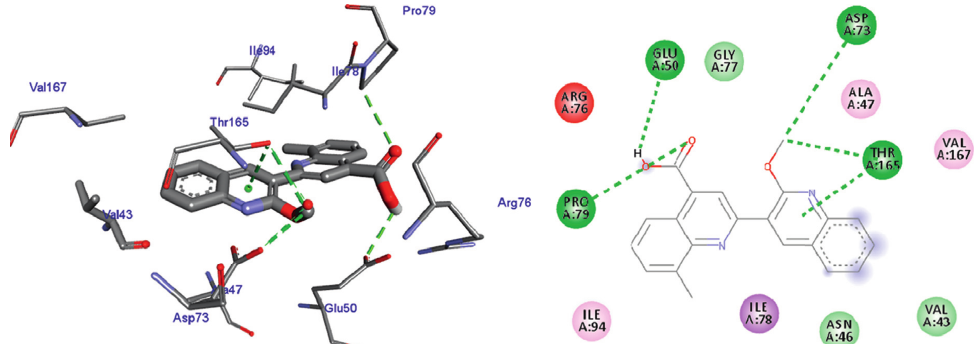
Figure 6: The binding interactions of 10 against E. coli DNA gyrase A (PDB ID: